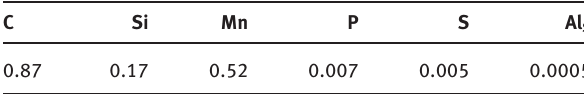
Table 1: Composition of initial steel/mass%.